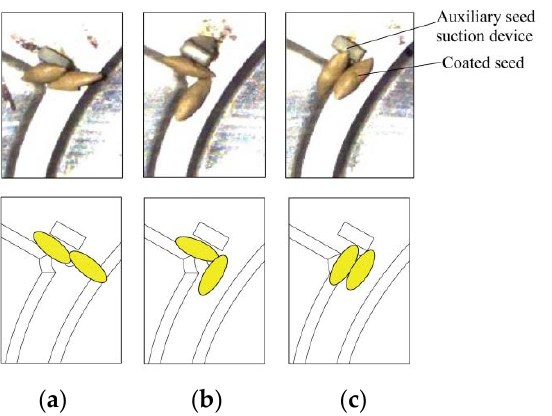
Figure 2. Posture of multiple rice seeds on suction holes: ( a ) posture 1; ( b ) posture 2; ( c ) posture 3. The type of seed metering device that was used was an air suction vertical disc-type seed metering device. Since the force of the rice seeds keeps changing during the rotation of the sucking plate, the unstable adsorption state will cause over-cleaning or leakage. In order to obtain the stable position of the adsorption state of the rice seeds and determine the installation position of the seed cleaning mechanism, the stress of the rice seeds in the seed-carrying area was analyzed. In order to display the force situation more intuitively, the three-dimensional coordinates, as shown in Figure 3, were constructed. The x axis is consistent with the tangential direction of the movement of the rice seed, the y axis is consistent with the radial direction of the rice seed’s movement, the z axis points to the direction of the suction force P 1 of the suction hole, and the center of the circle O ′ is at the centroids of the rice seeds. When the rice seeds move to the seed-carrying area with the seed suction tray, assuming that the coated rice seeds are adsorbed stably in the seed-carrying area, they will not be affected by the force of the auxiliary seed suction device on the coated rice seeds. The force is the suction force P 1 at the suction hole, the seed gravity G , the inertial force J caused by the seed acceleration, the N force is the normal reaction force of the suction hole to the seed, and R is the radius of the circle where the suction hole is located.